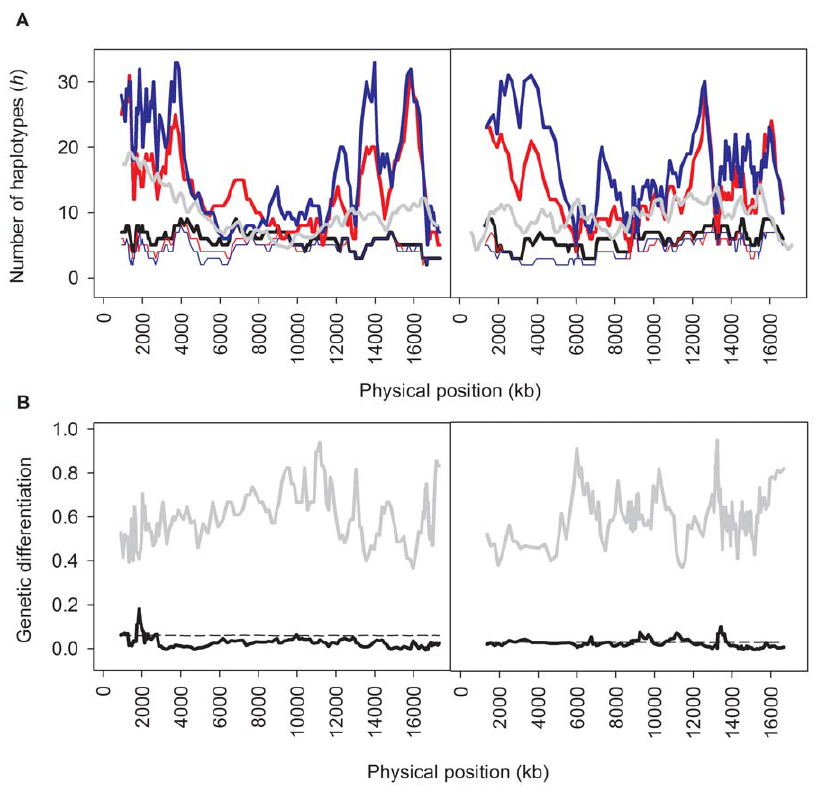
Figure 3. Genetic diversity and differentiation among ancestral populations. A shows the number of haplotypes, calculated in 10 SNP windows and step sizes of 1 SNP, along the physical distance (see also Figure S2 ); red=androdioecious population; blue=dioecious population. Black line indicates the number of haplotypes among the 16 wild isolates used as parentals. Grey line shows the diversity found among worldwide collections of C. elegans isolates, as recalculated from [40] (see Materials and Methods ). Thin colored lines show the number of parental isolate haplotypes identified in the two ancestral populations. B , the grey line indicates the number of shared haplotypes among the two ancestral populations, shown in 10 SNP-wide windows and step sizes of 1 SNP, as calculated by the proportion of the total number of haplotypes common to both populations. Black lines show the F ST estimated from these shared haplotypes with their significance, obtained by permutation of SNP position within each chromosome, the latter shown as a dashed line. All positions are haplotype centered.